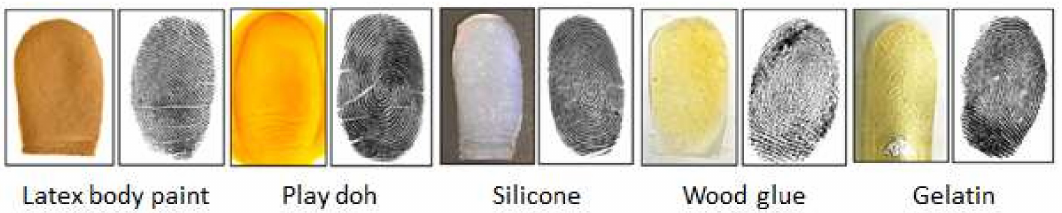
Figure 1. Different examples of spoof fingerprints fabricated using different materials. The photograph of the fabricated fingerprint is on the left, and the captured fingerprint image using Crossmatch sensor is on the right